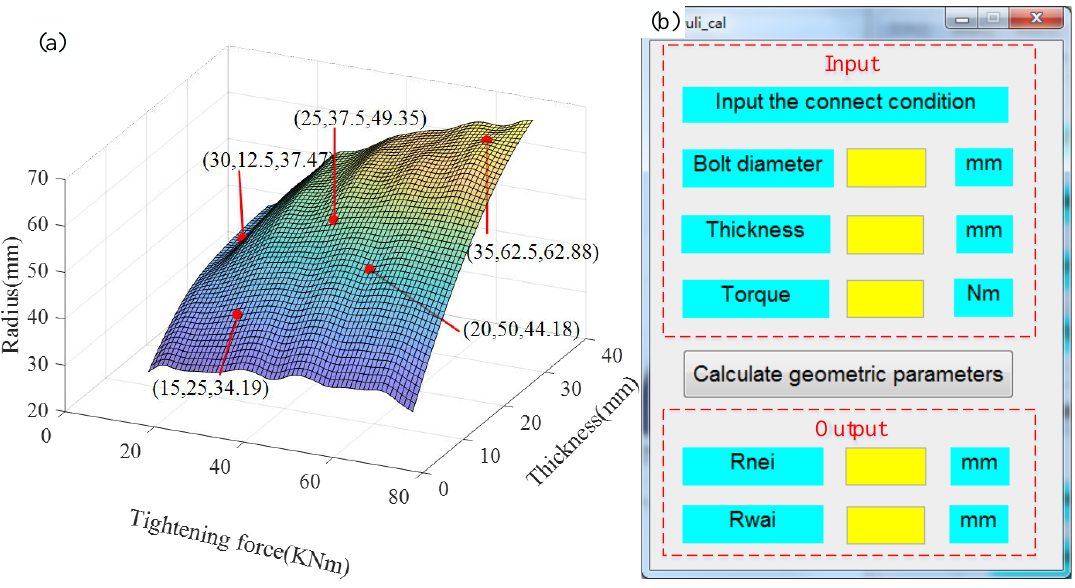
Figure 7. Geometric database: ( a ) Kriging model, ( b ) database management interface.